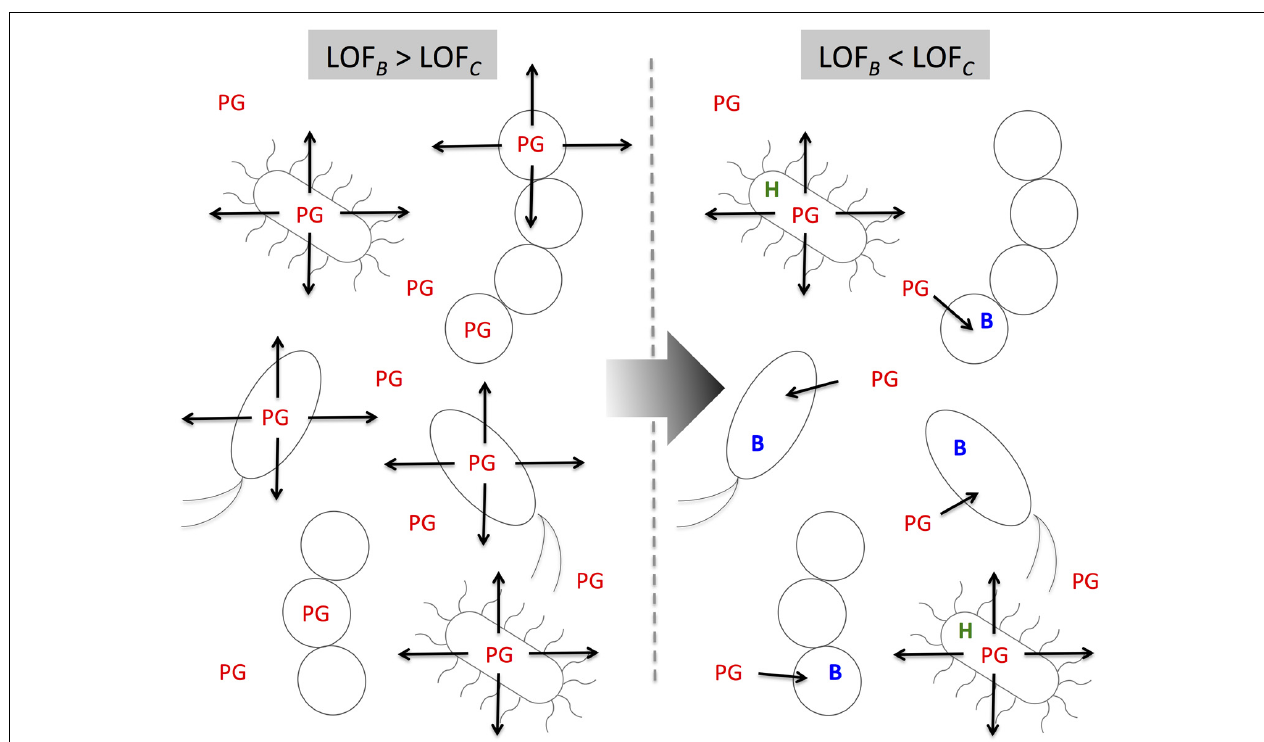
FIGURE 3 |The Black Queen Hypothesis predicts that if there is a community where different species produce an expensive and diffusible public good (PG), the system will evolve toward a scenario where only a few of their members will continue with the production of the PG, only